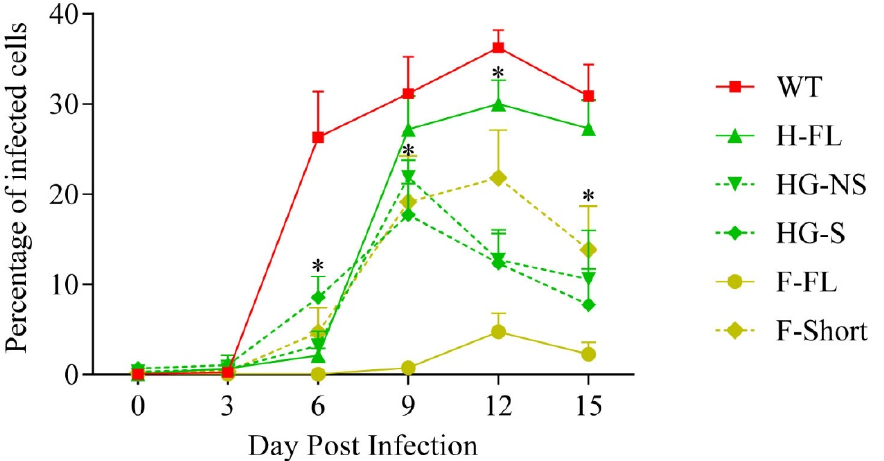
Figure 3. Growth of MAV-1 recombinants. 3T6 cells were infected with 500 TCID50 of the different MAV-1 strains and harvested at the indicated time points to titer virus production as described in the methods. The data presented are means for triplicated measurements ± SEM. p values are relative to comparison with the growth of MAV-1 WT strain. *, p < 0.05.